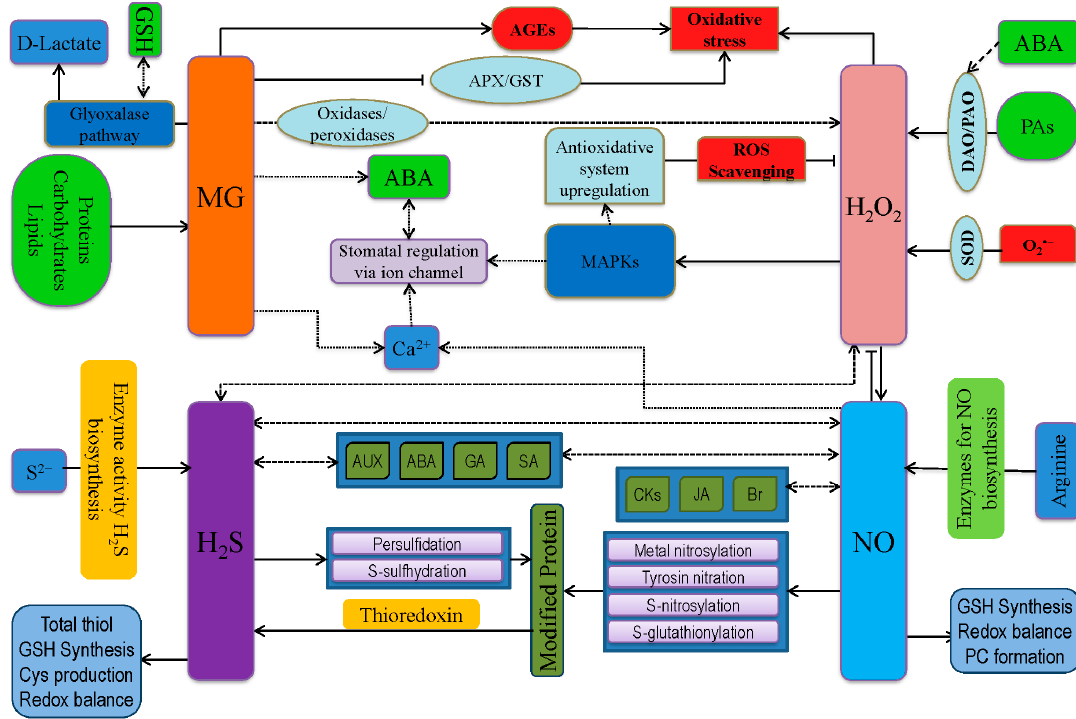
Figure 6. Cross-talk among vital ROS (H 2 O 2 ), RNS (NO), RSS (H 2 S), and RCS (MG) in plant cells for oxidative stress and defense response in plants. APX, ascorbate peroxidase; AUX, auxin; ET, ethylene; ABA, abscisic acid; ROS, reactive oxygen species; GSH, reduced glutathione; JA, jasmonates, MAPKs, mitogen-activated protein kinases; SA, salicylic acid; AEGs, advanced glycation end products; PAs, polyamines; MG, methylglyoxal; NO, nitric oxide; H 2 S, hydrogen sulfide. Dotted lines represent activation/enhancement.